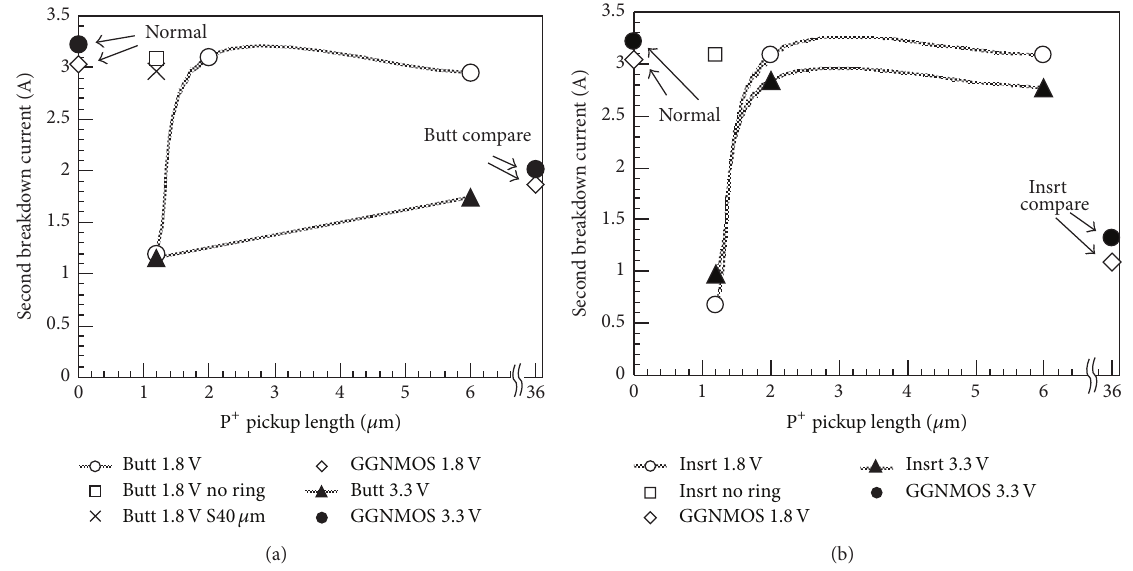
Figure 4: (a) TLP 𝐼 t 2 comparison among the GGNMOS and various butting substrate pickup styles with respect to the pickup length. (b) TLP 𝐼 t 2 comparison among the GGNMOS and various inserted substrate pickup styles with respect to the pickup